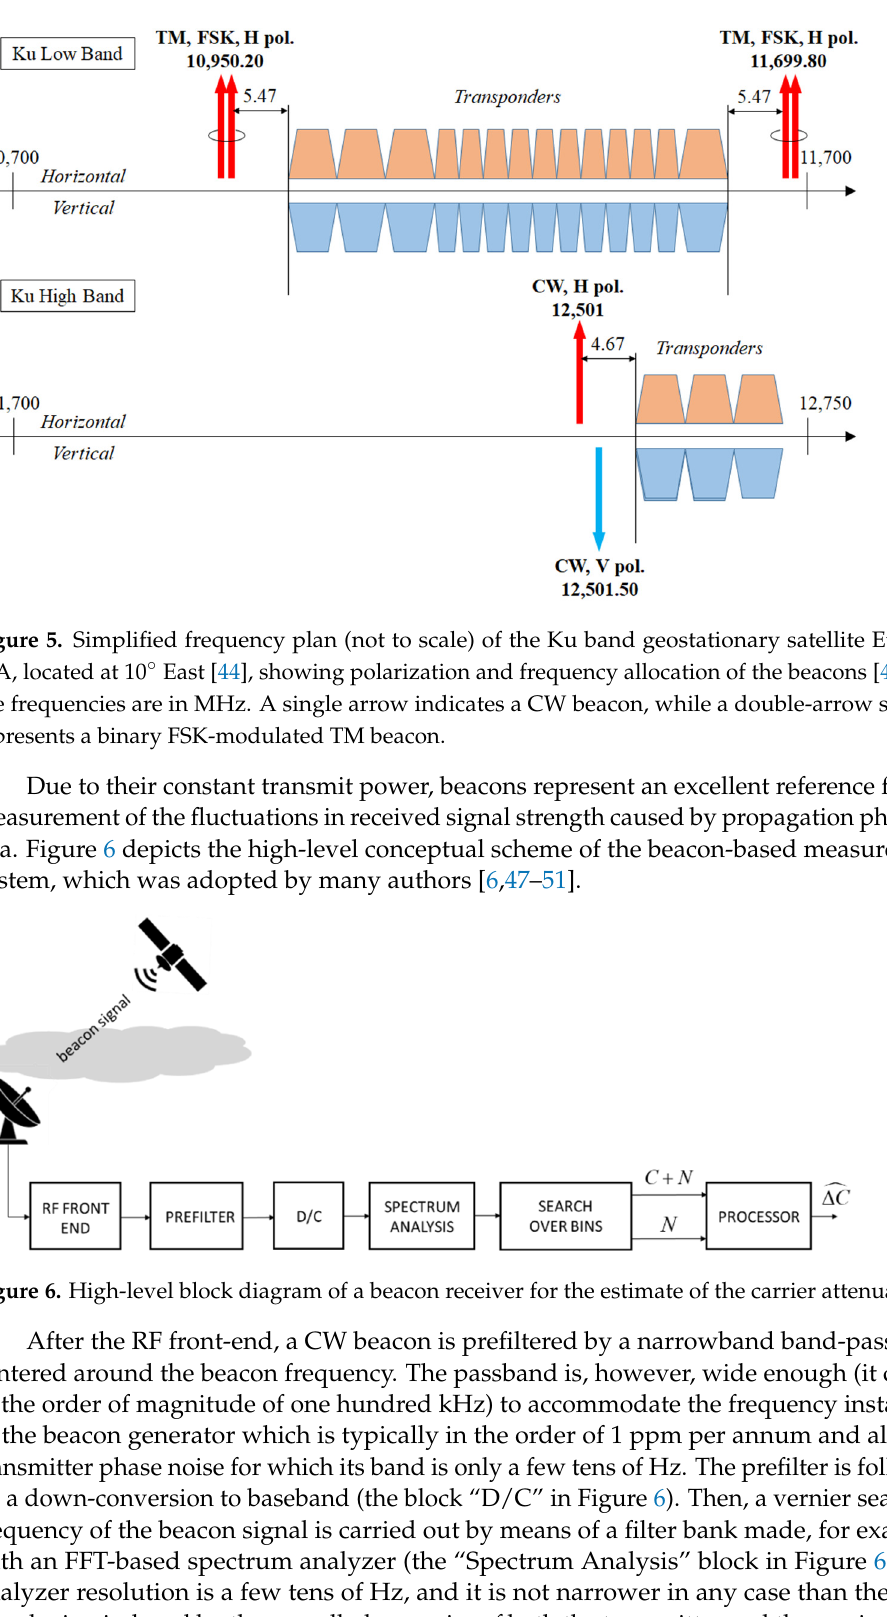
Figure 6. High-level block diagram of a beacon receiver for the estimate of the carrier